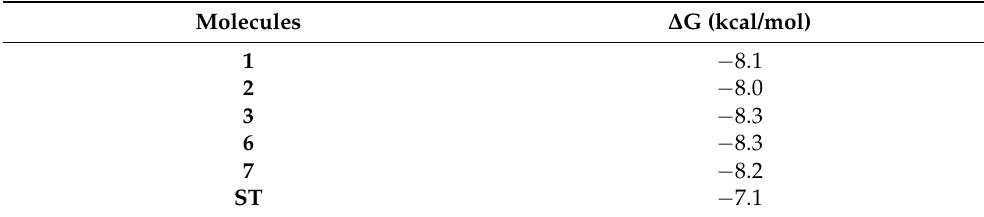
Table 5. Scoring values ( ∆ G) of molecules 1–3 , 6–7 , and ST .